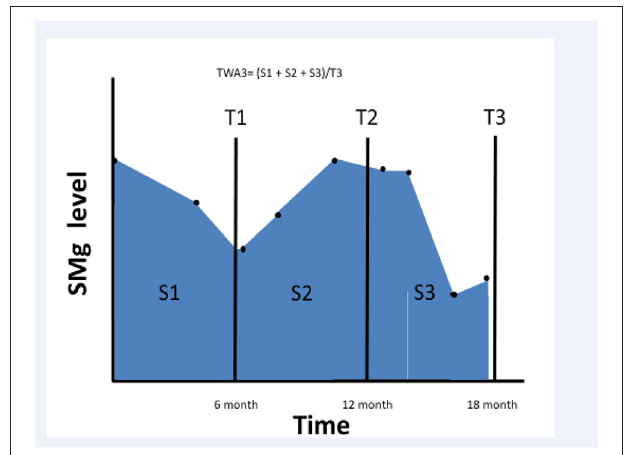
FIGURE 1 | Schematic description of sMg TWA